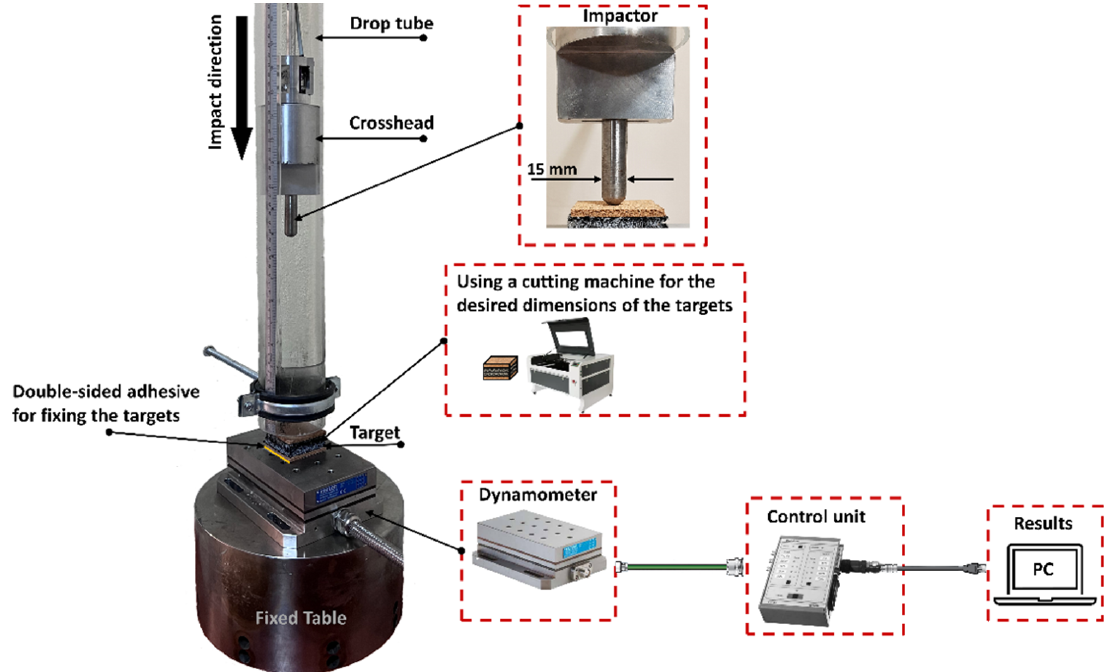
Figure 1. Drop ‐ weight impact machine. Figure 1. Drop-weight impact machine.